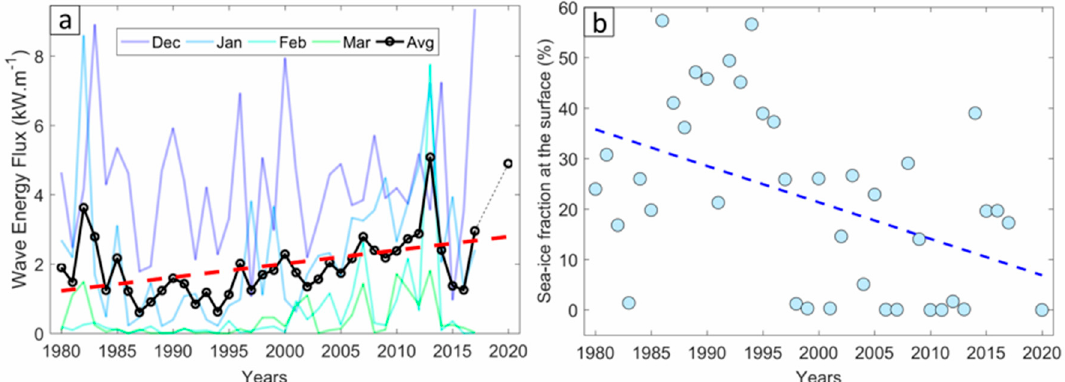
Figure 23. ( a ) Evolution of the winter-averaged wave energy flux for the 1980–2020 period. The colored lines show the evolution according to the month and the black line the average for the whole winter. The trend of the wave energy flux is highlighted by the linear regression in red (dashed line). ( b ) Evolution of the ice coverage at the sea-surface during the winter over the 1980–2020 period. The trend of the sea-ice fraction is highlighted by the linear regression in blue (dashed line).